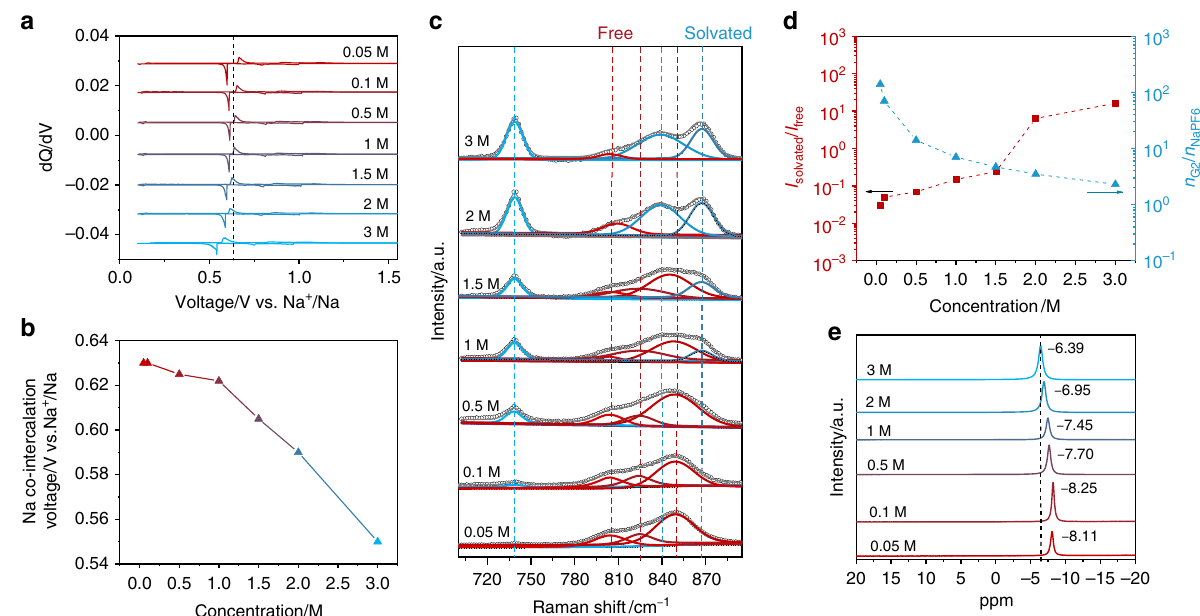
Fig. 2 Co-intercalation voltage change with electrolyte concentrations. a dQ / dV curves of graphite anodes cycled in NaPF 6 G 2 electrolytes with concentrations from 0.05 to 3 M at 35 °C. b Average co-intercalation voltages in Na half-cells derived from ( a ) plotted as a function of electrolyte concentration. c Deconvoluted Raman spectra of electrolytes for different concentrations. The peak at ~738 cm − 1 that corresponds to the P – F bond from PF 6 − anion increases in the intensity monotonously with the salt concentration, implying that the electrolytes were well prepared for targeted compositions. d Intensity ratio of Raman peak between solvated solvent to free solvent and the molar ratio of G 2 solvent to NaPF 6 salt. e 23 Na NMR spectra of electrolytes as a function of